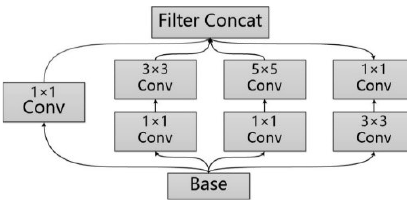
Figure 3. Module of Inception.